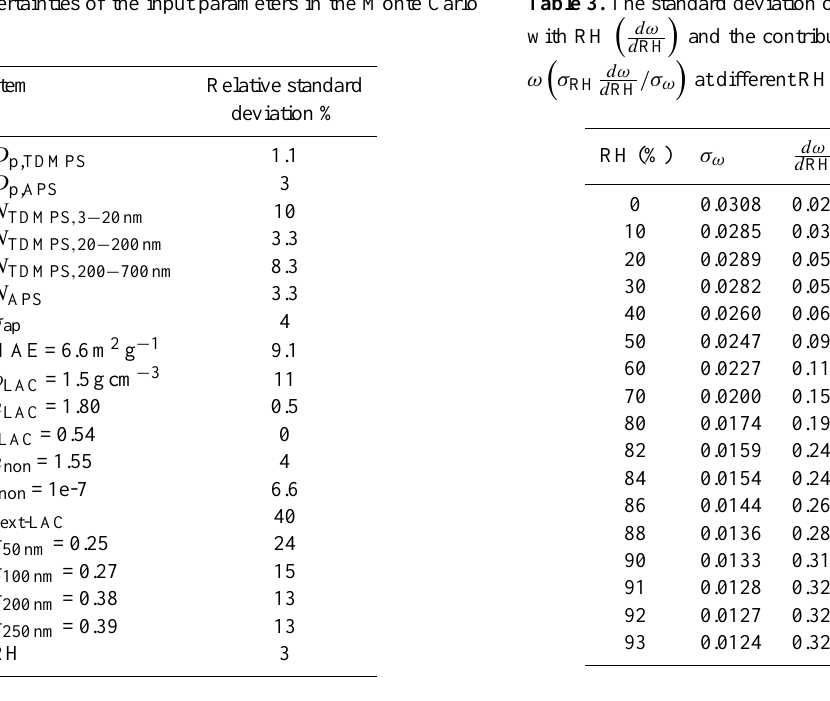
Fig. 6, the UVB irradiation in all cases near the ground (the solid lines) decrease as τ rises. The decrease of the low- ω case is stronger than that of the high- ω case. For the AVG- low- ω case to high- ω case can be recognized.